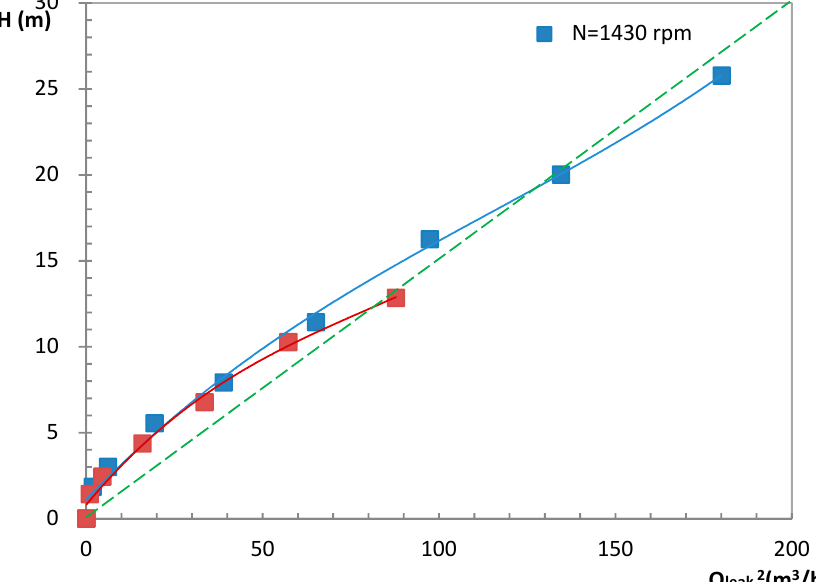
Figure 10. Comparison between experimental leakage values. The dashed straight green line, H = f (Q leak2 ), corresponds to a theoretical law evolution based on turbulent flow regime assumption.